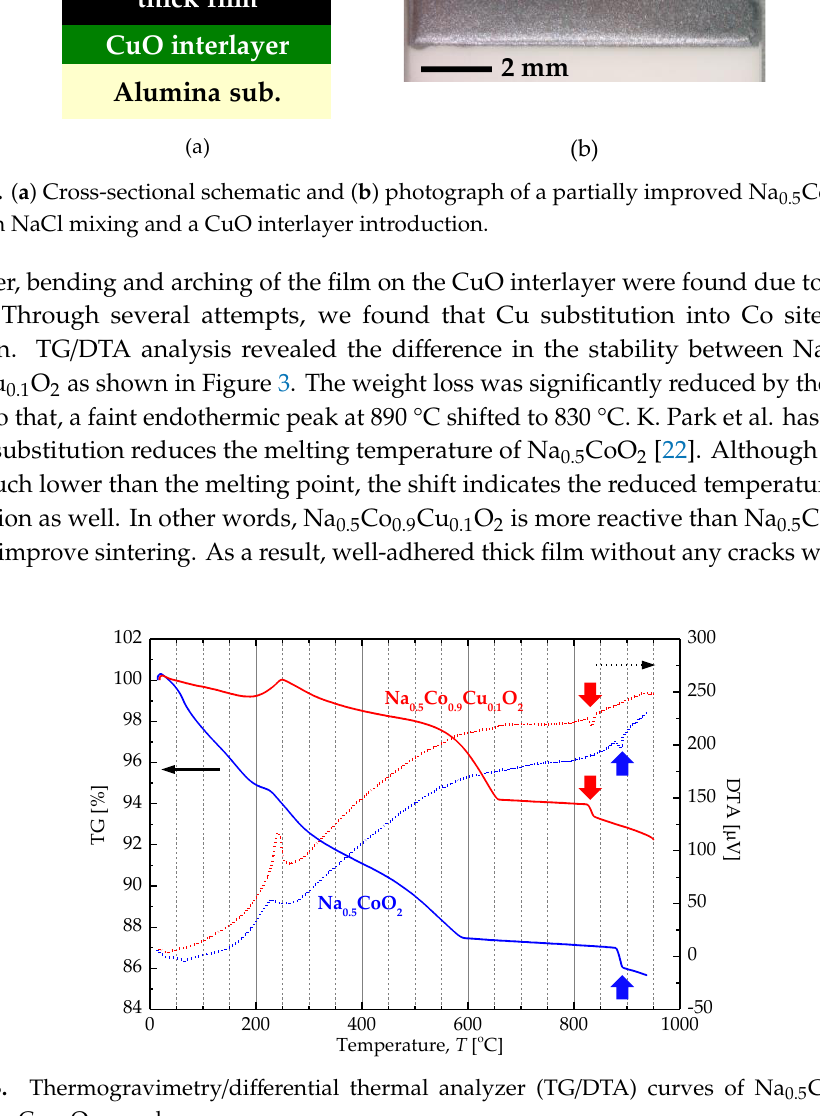
Figure 3. Thermogravimetry/differential thermal analyzer (TG/DTA) curves of Na 0.5 CoO 2 and Na 0.5 Co 0.9 Cu 0.1 O 2 powders.